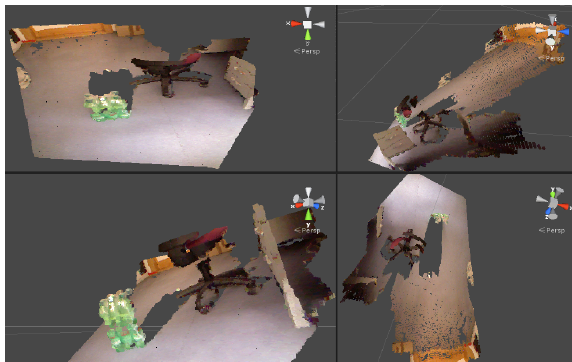
Figure 6 - Different viewing angles of the same point cloud.